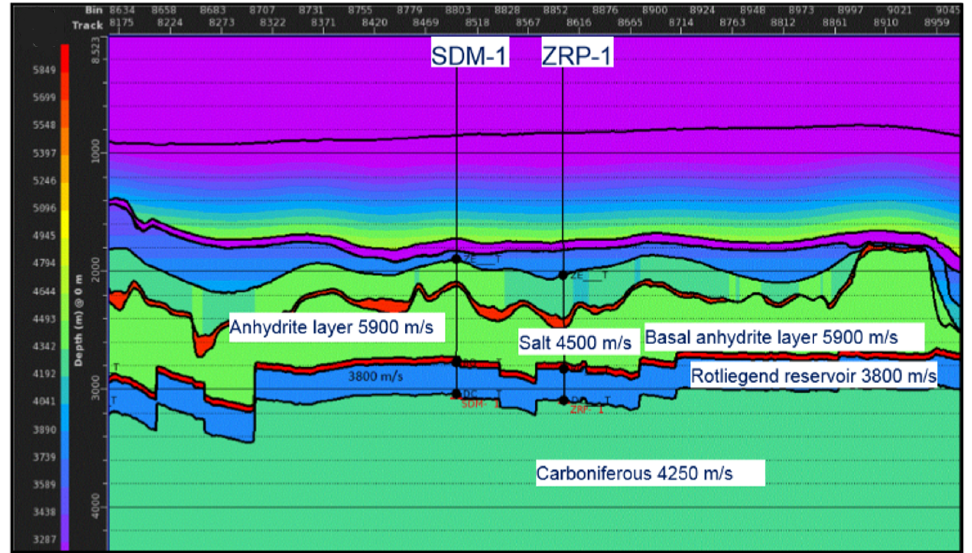
Figure 4. Overview of the geology in the SDM-1 well proximity [4]; provided by the Nederlandse Aardolie Maatschappij (NAM). The target of micro-seismic monitoring is the Rotliegend gas reservoir, lying under the basal anhydrite layer and above the Carboniferous